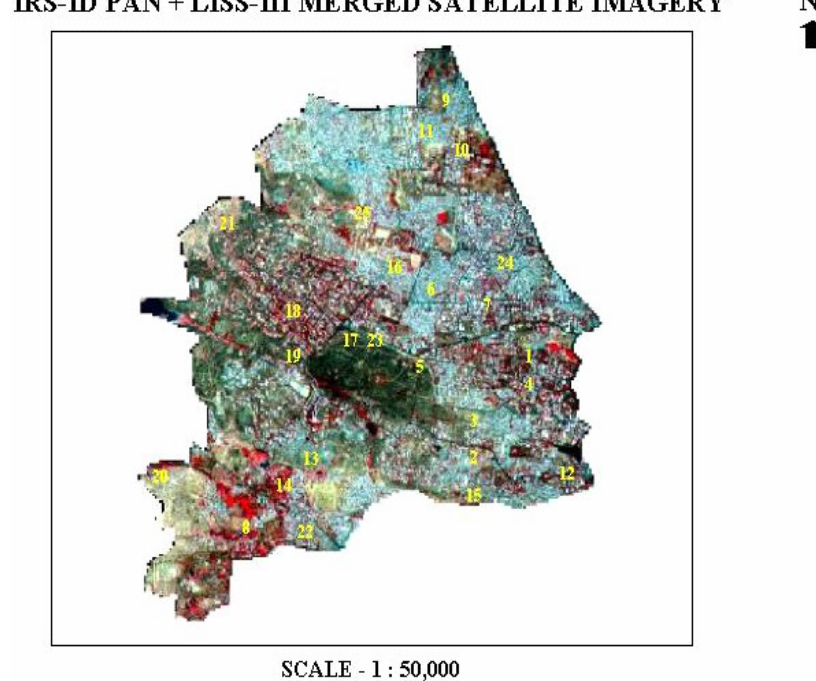
Figure 2: Sampling points overlaid on satellite